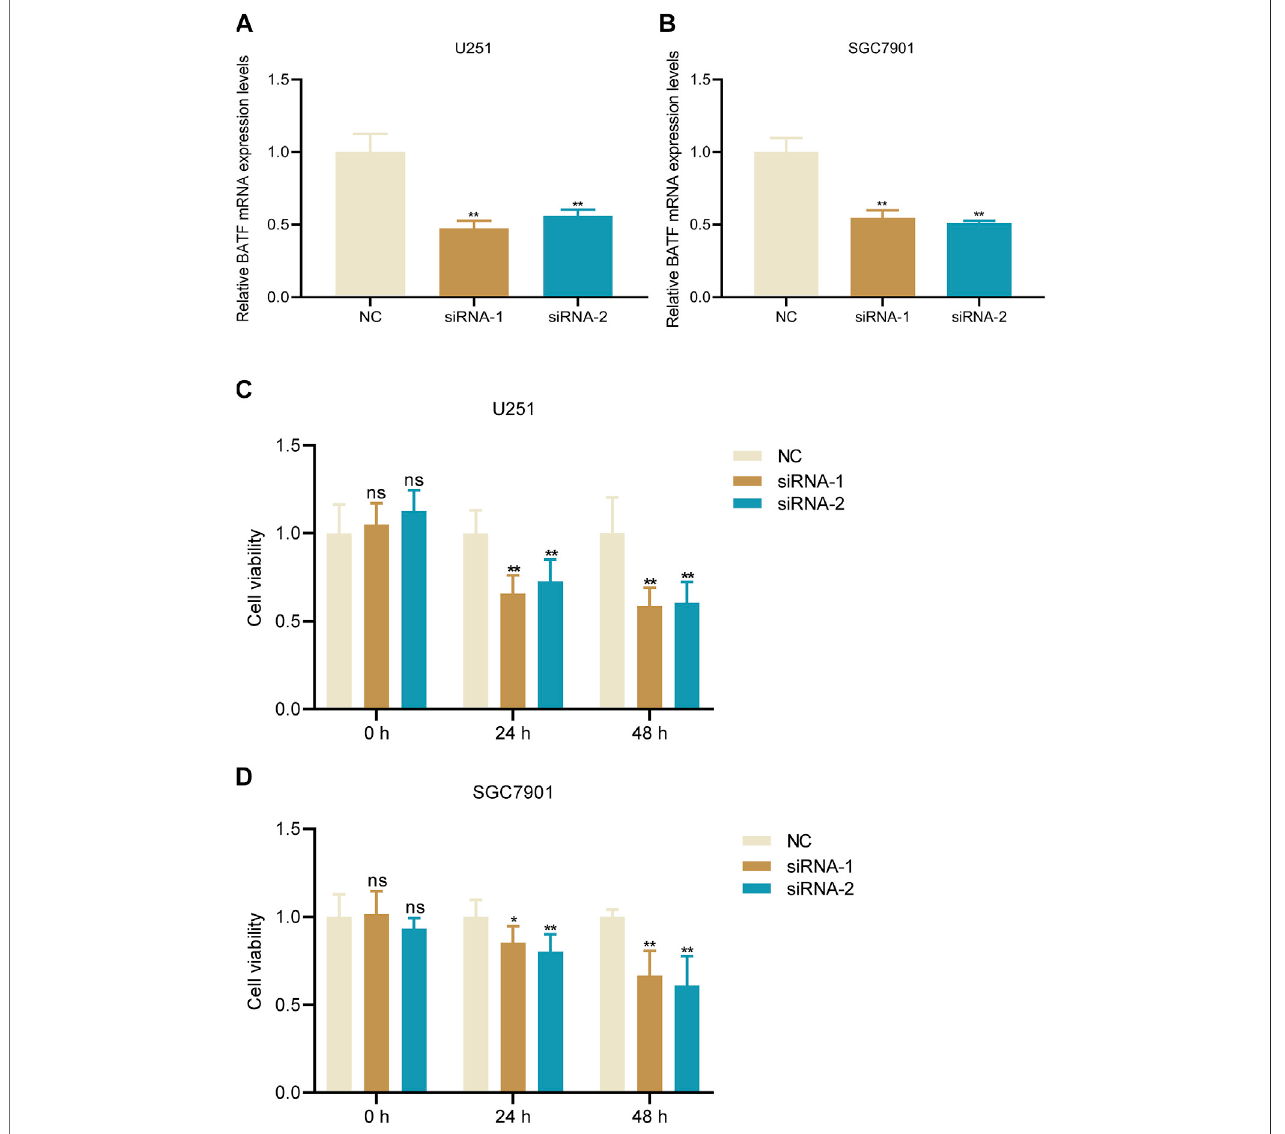
FIGURE 11 | Knockdown of BATF suppresses tumor cell viability. (A,B) BATF knockdown decreases BATF mRNA expression in U251 and SGC7901 cells. ** p < 0.01 vs. NC. (C,D) Knockdown of BATF inhibits U251 and SGC7901 cell viability. * p < 0.05; ** p < 0.01 vs.